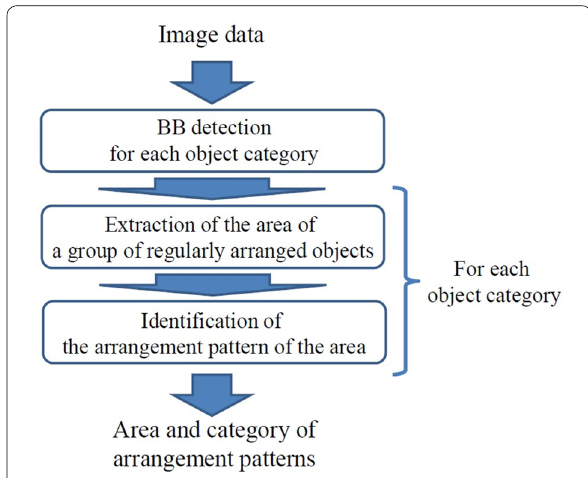
a model fine-tuned from an existing model [29] pre-